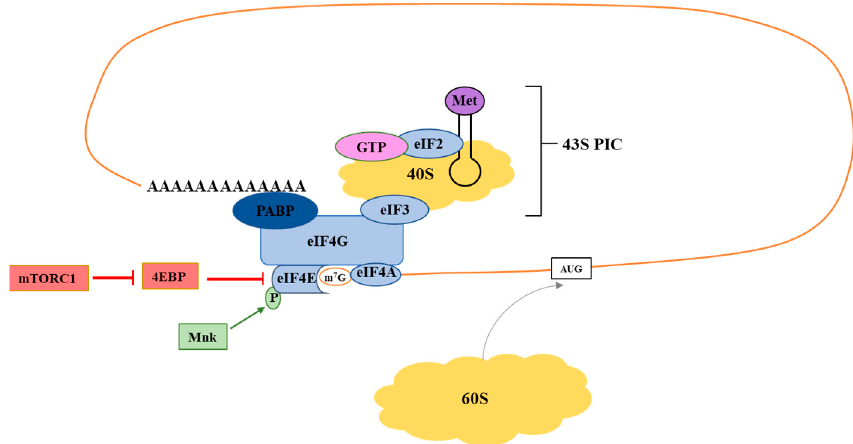
Figure 1. Overview of cap-dependent translational initiation. The eIF4F complex consists of